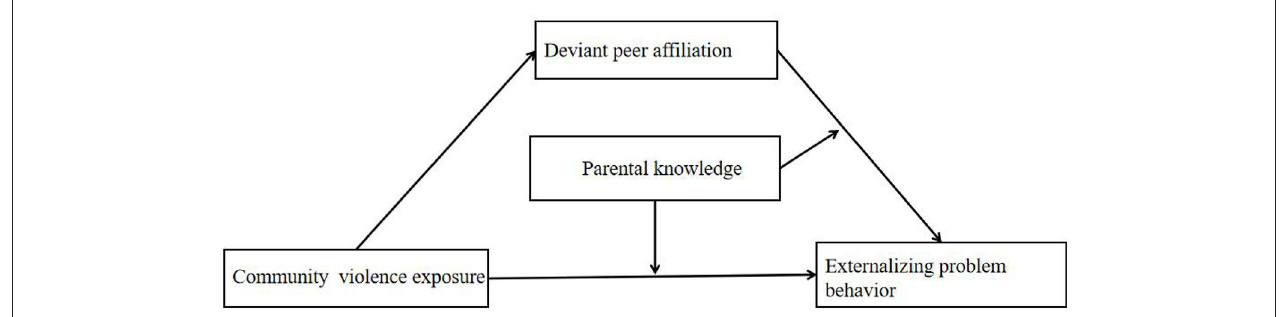
FIGURE 1 | Conceptual framework of the proposed moderated mediation model.